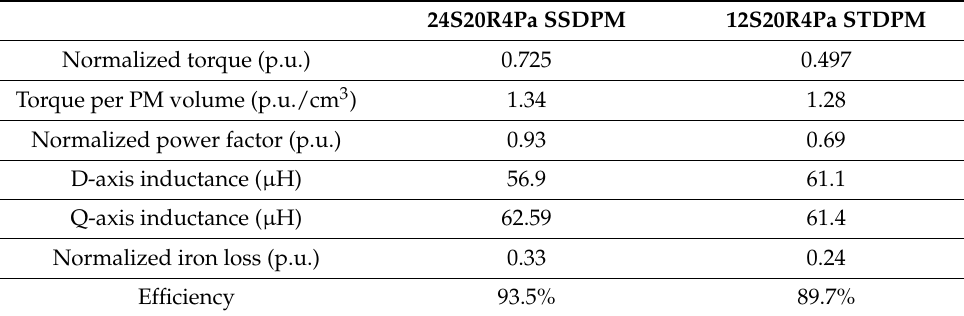
Normalized power factor